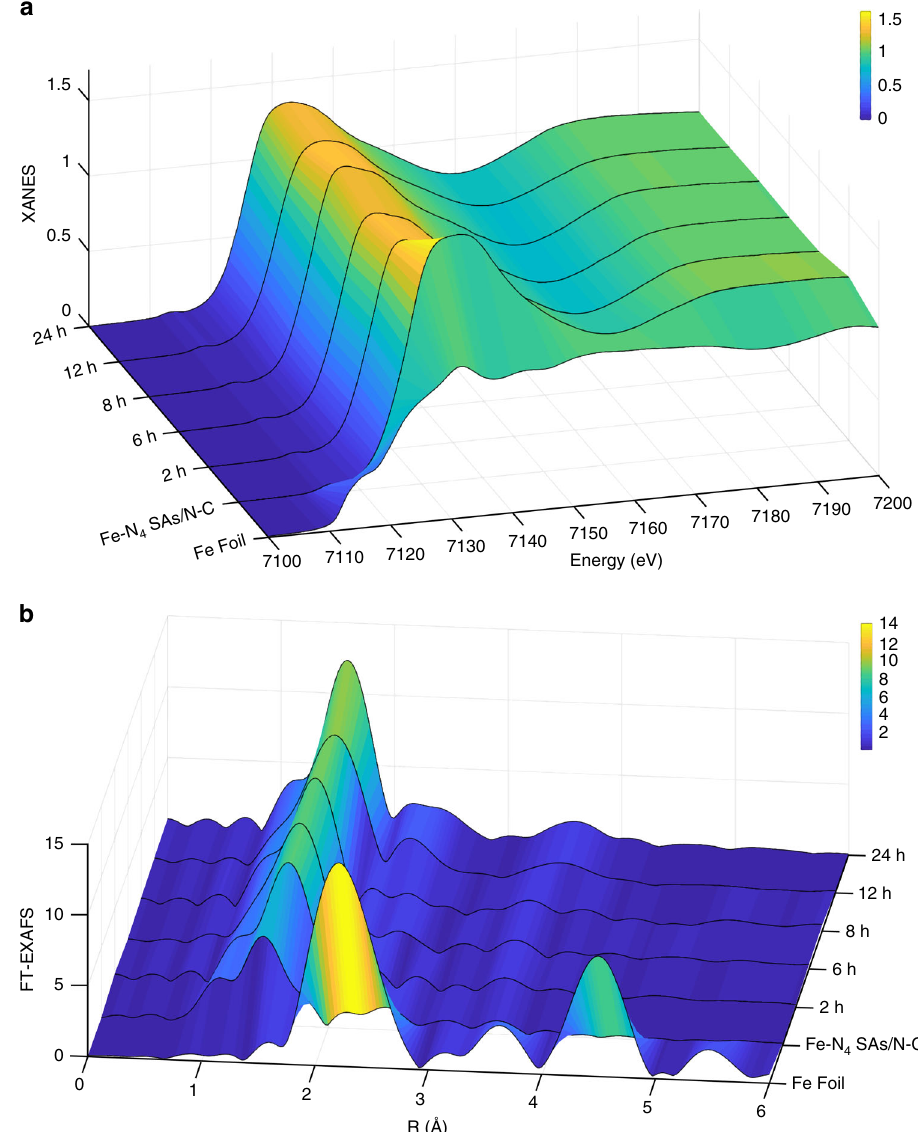
Fig. 4 Stability investigations. a , b The Fe K-edge a XANES and b FT-EXAFS of Fe-N 4 SAs/N-C catalyst at different BOR reaction